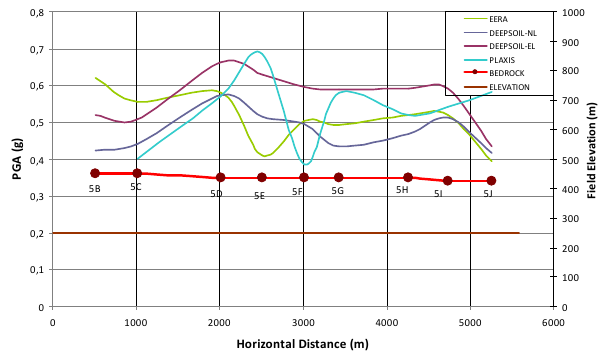
Figure 20. For the 5-5 0 section, a simplified model in which the surface and material borders are assumed to be flat.